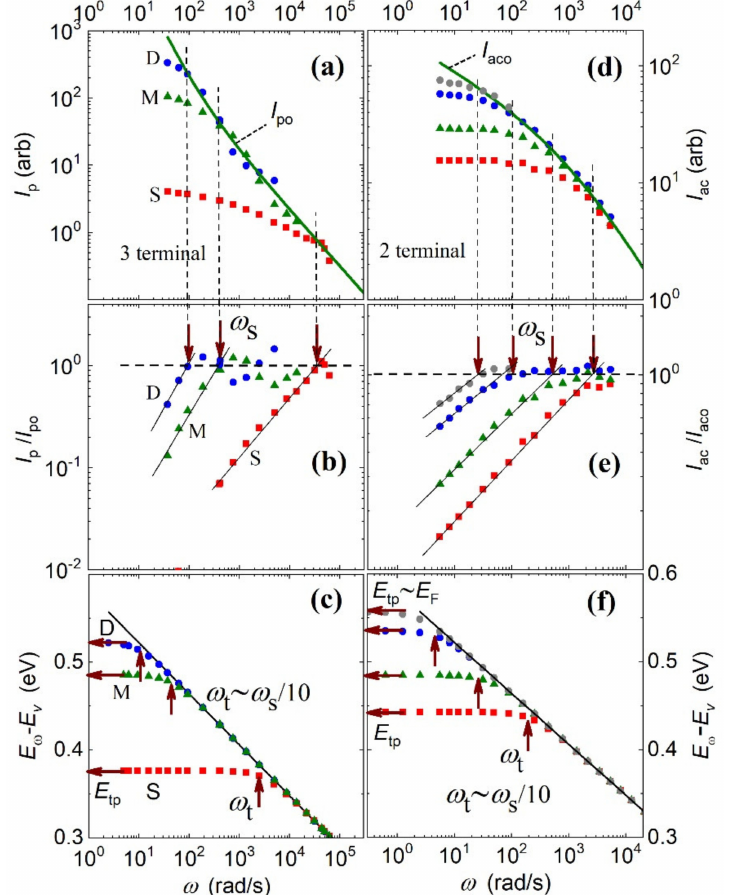
Figure 4. Photocurrent spectra of three-terminal pentacene FETs compared with the photocur- rent spectra of two-terminal pentacene films on glass substrate. Spectra of photocurrent I p ( ω ) ( a ), I p ( ω )/ I po ( ω ) ratio ( b ), and probed trap depth ( E ω − E v ) ( c ) of pentacene FETs obtained for probe laser beam placed near the source (S) (red squares), midway the source and drain (M) (olive triangles), and near the drain side (D) (blue circles). Spectra of the MPC amplitude I ac ( ω ) ( d ), I ac ( ω )/I aco ( ω ) ratio ( e ), and probed trap depth ( E ω − E v ) ( f ) of pentacene two-terminal devices typically obtained by increasing intensity of the bias light: 1.2 × 10 11 (grey circles), 7.5 × 10 11 (blue circles), 4 × 10 12 (olive triangles), 1.8 × 10 13 (red squares) photons cm − 2 s − 1 . Down and up arrows indicate frequencies ω s and ω t , respectively. Horizontal arrows indicate E tp level. Solid straight lines indicate ( E ω − E v ) calculated from Equation